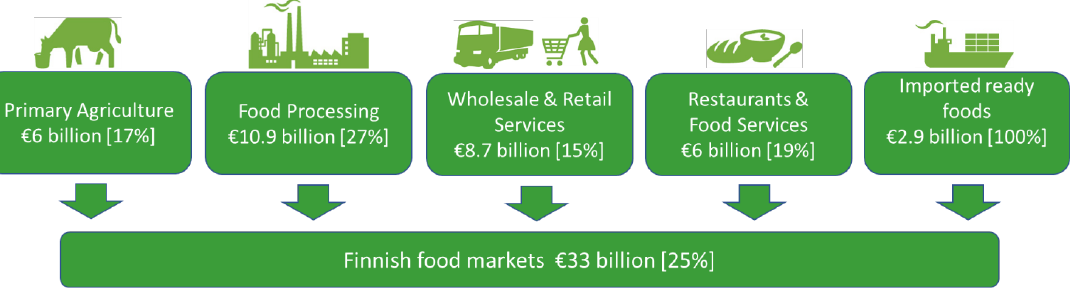
Fig. 1. The total value of Finnish food markets and dependency on imports (in percentage) in 2016 (Knuuttila and Vatanen